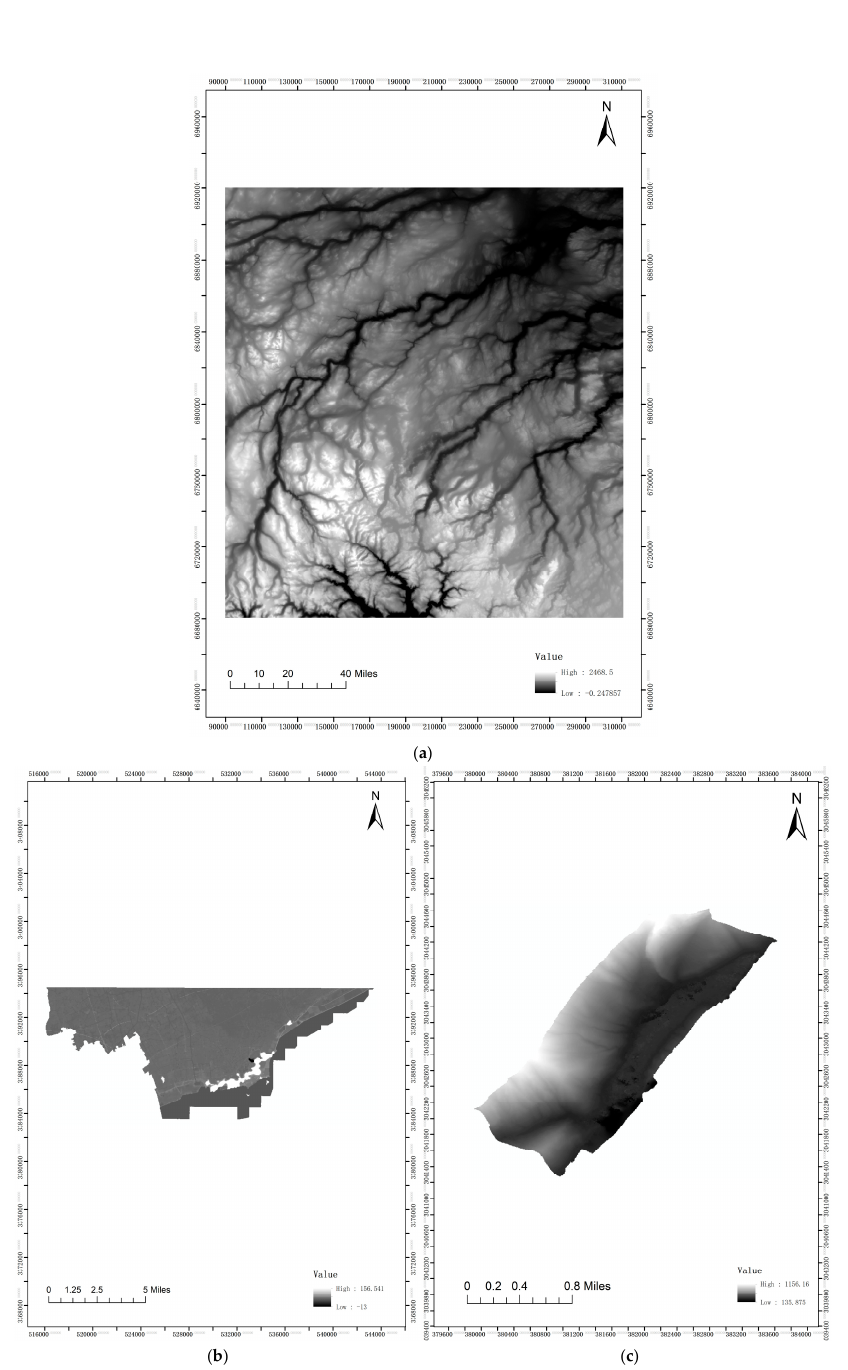
Figure 3. DEM data. ( a ) Data of Norway; ( b ) data of a place in Jiangsu province; and ( c ) data of a place in Sichuan